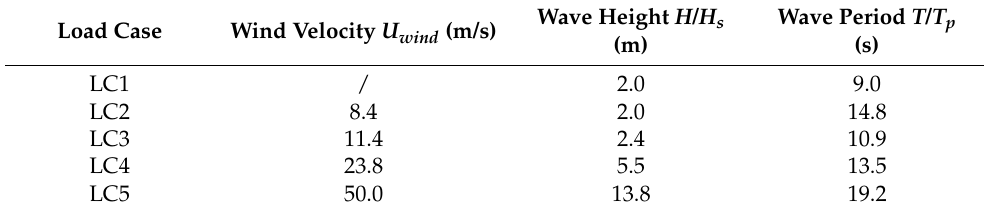
Table 3. Load cases table.